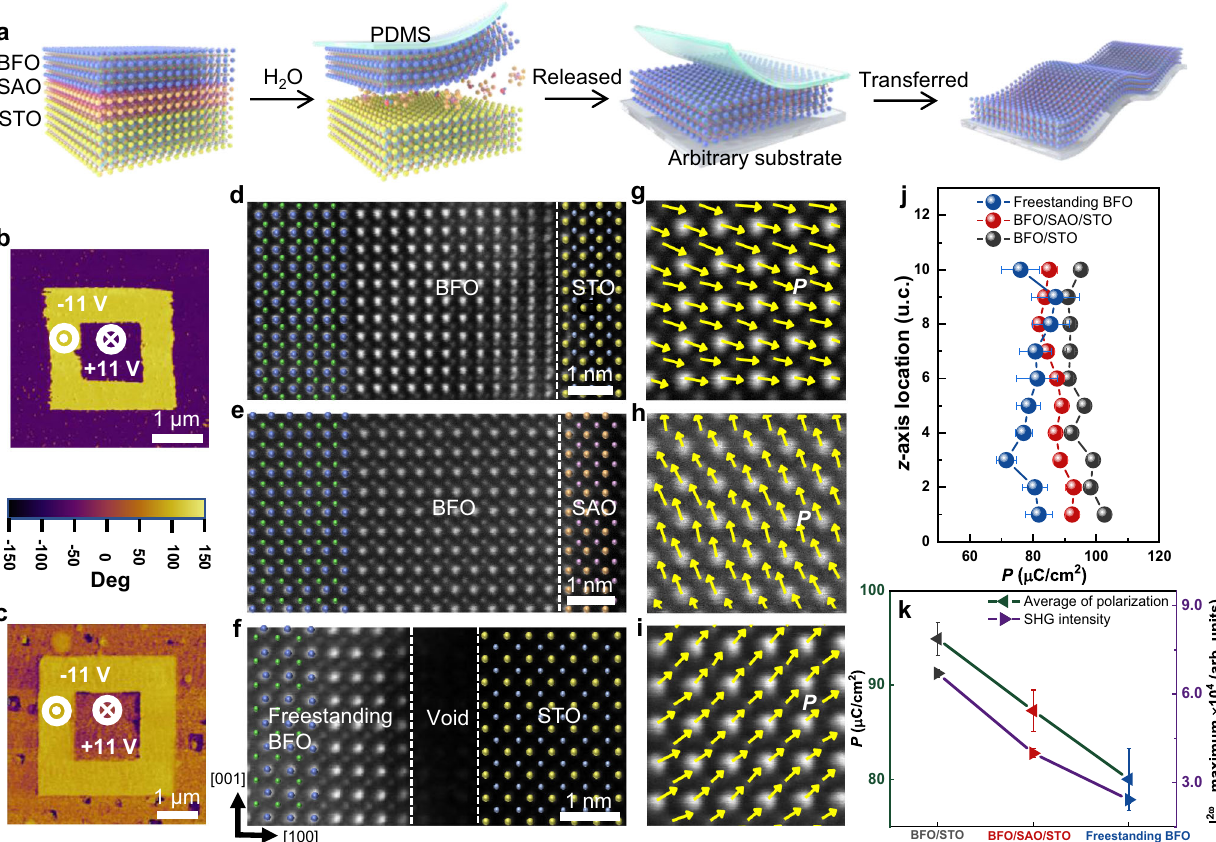
Fig. 1 | Preparation and ferroelectric properties characterization of BFO fi lms. a Schematics of the whole fabrication process: from BFO/SAO/STO hetero- structures to freestanding BFO fi lms. b , c Out-of-plane PFM phase images of the epitaxial BFO fi lms and the freestanding BFO fi lms, respectively. d – f The cross- sectional STEM-HAADF images of BFO/STO, BFO/SAO/STO, and freestanding BFO transferred on STO, respectively. g – i The visualization of polarization in the cor- responding fi lms in d – f . The yellow arrows are plotted according to the